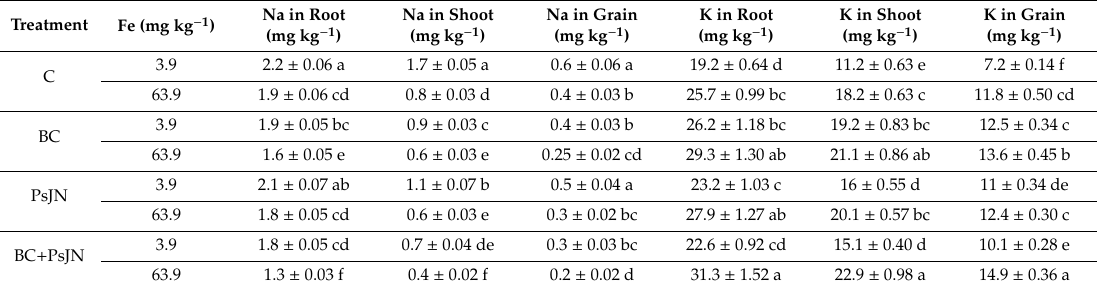
Table 4. The e ff ect of biochar- Burkholderia phytofirmans PsJN integration on chemical parameters (Na and K) of Chenopodium quinoa under salinity stress.